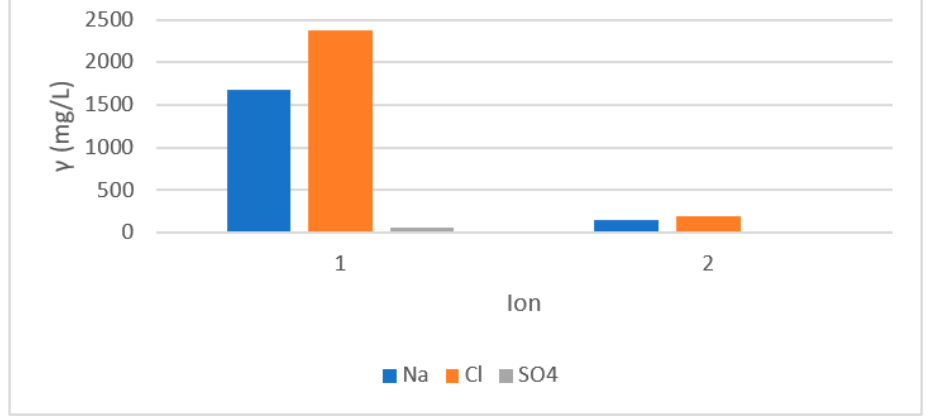
Figure 4. Mass concentration in feed (denoted 1) and permeate (denoted2).